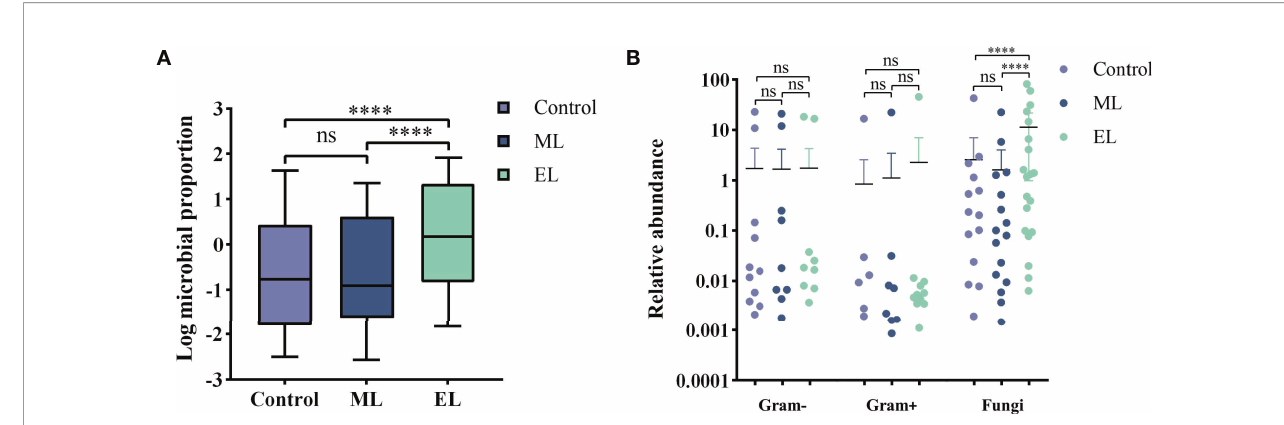
FIGURE 5 | Evaluation of the DNA extraction ef fi ciency for the three DNA extraction methods. **** P < 0.0001; ns, nonsigni fi cant. (A) Boxplot of Log proportion of microbial reads in total reads generated by MinION. Median values are indicated by the line within the boxplot. The box extends from the 25th to 75th percentiles, and whiskers indicate the minimum and maximum values. (B) Relative abundance difference for different types of species by different DNA extraction